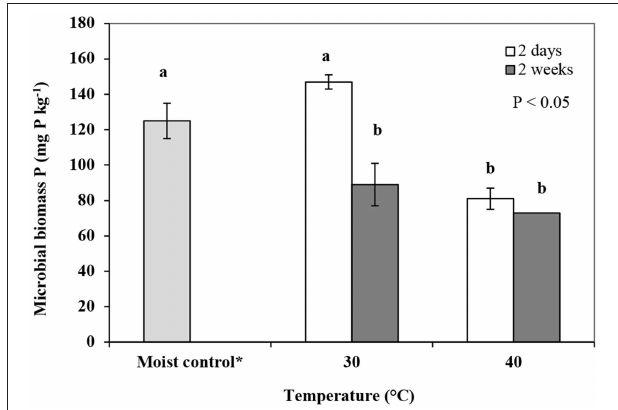
FIGURE 5 | Microbial biomass phosphorus (mg P kg − 1 ) extracted in samples fumigated followed by drying for 2 and 14-days (FD) treatments at 30 and 40 ◦ C. Error bars represent standard deviation, n = 3. Means with the same letter(s) are not statistically significant from each other i.e., P > 0.05 as determined using a Tukey post-hoc test. *Moist control is reference moist soil (MF) stored at 3 ◦